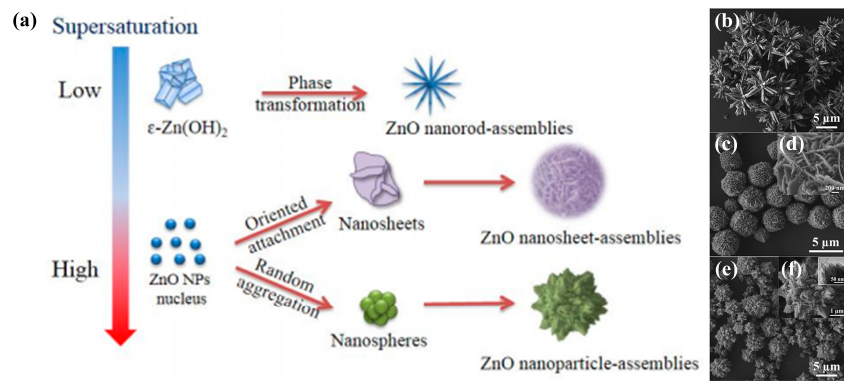
Figure 8. Schematic illustration for the formation mechanisms of ZnO hierarchical structures ( a ) and different SEM images of different morphologies of hierarchical ZnO nanostructures ( b – f ) (Reproduced with permission from [89]. Copyright 2014, Royal Society of Chemistry, London).